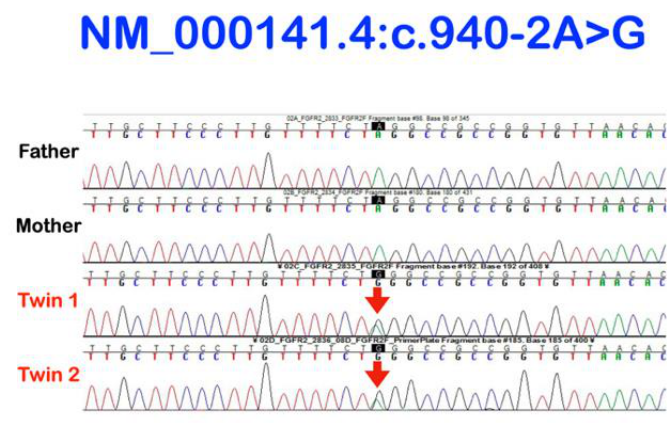
Figure 7. Electropherograms of a FGFR2 mutation. A de novo heterozygous base substitution NM_000141.4:c.940-2A>G in intron 8 at the 3′ splice acceptor site of the FGFR2 gene, leading to abnormal IIIc acceptor splicing in both twins. The parents did not have the mutation.